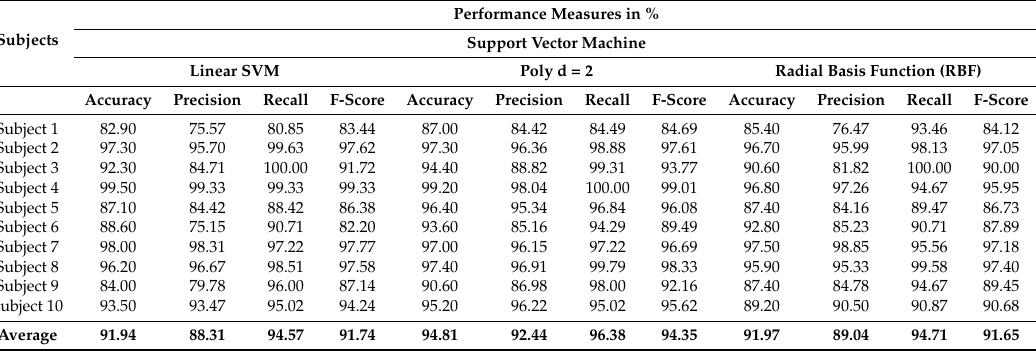
91.94 Table 3. 10-fold cross validation (10-CV) identification results using linear and kernel-based (polynomial d = 2 and radial basis function) support vector machine (SVM) including accuracy, precision, recall and F-Score generated with 18D feature